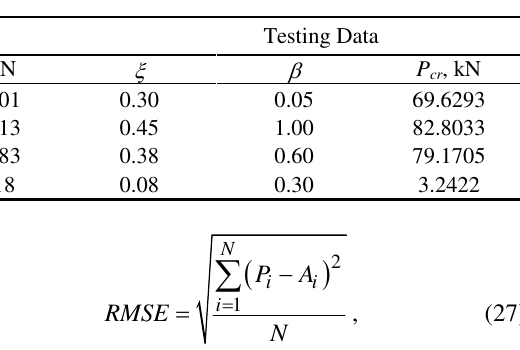
Table 2. The ranges and statistical details of the model variables